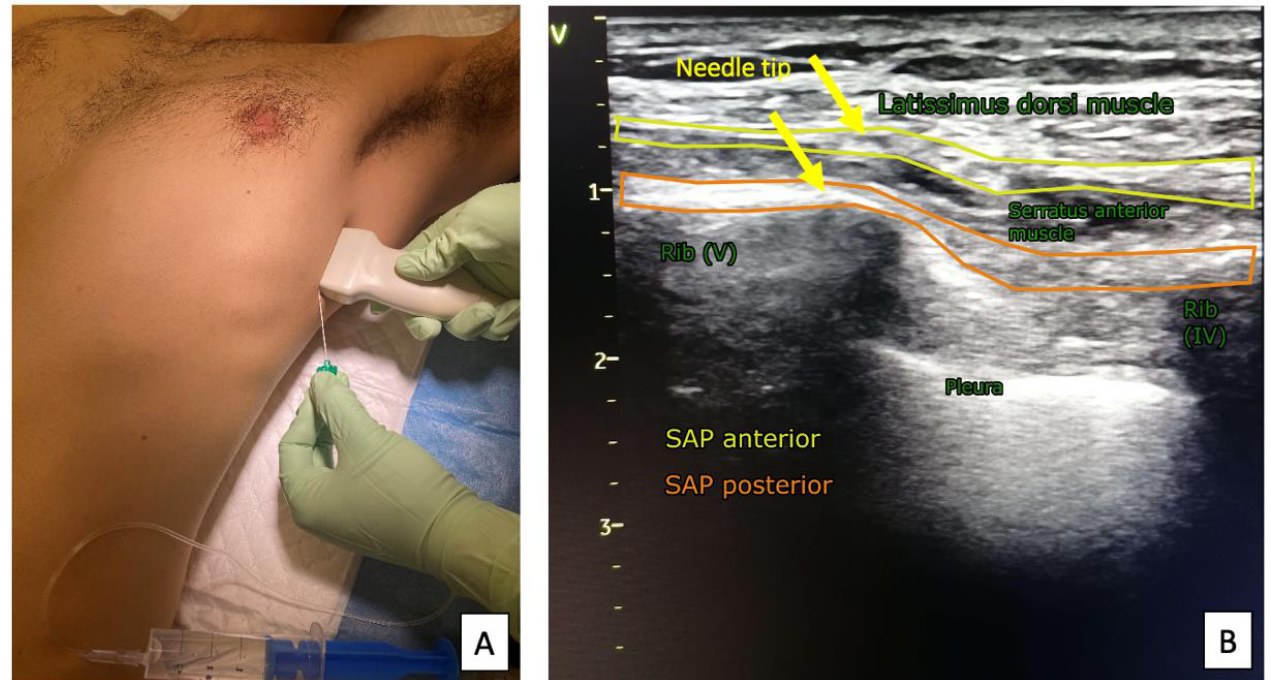
Figure 5. Ultrasound transducer positioning ( A ) and sonoanatomy of the SAP block ( B ). Application: The SAP block is used in mini-thoracotomies and classical thoracotomies; thoracoscopy;